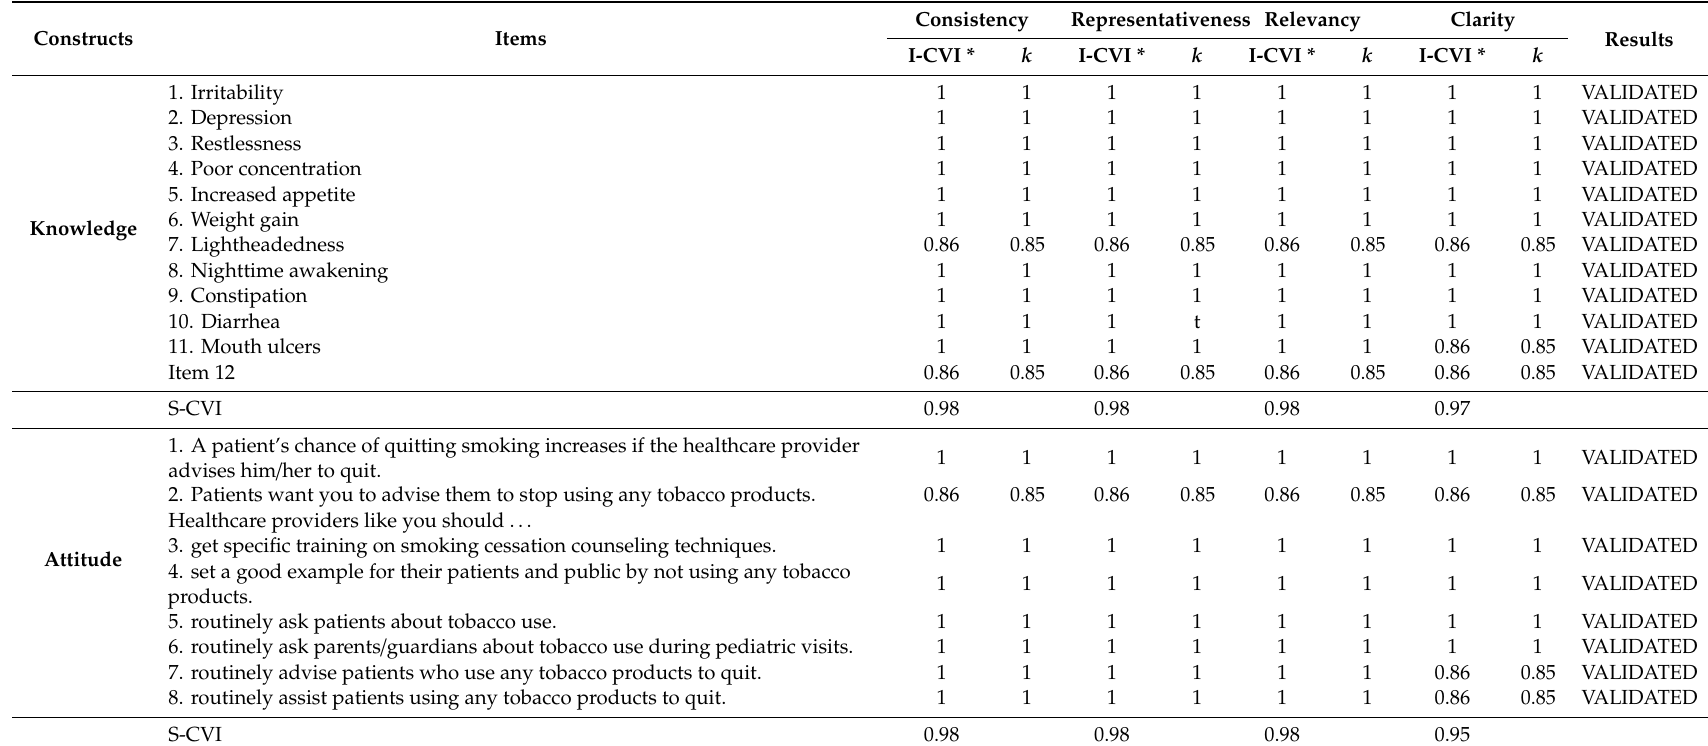
Table 3. Content validity of the ProSCiTE